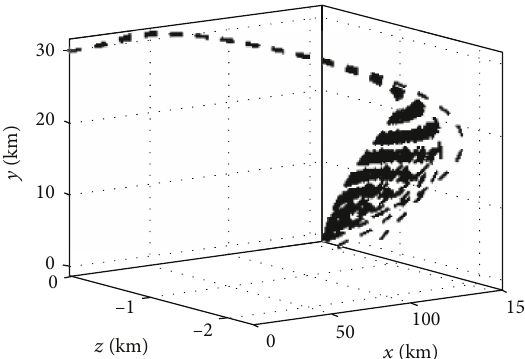
Figure 19: Curves representing the attack, sideslip, and bank angles.